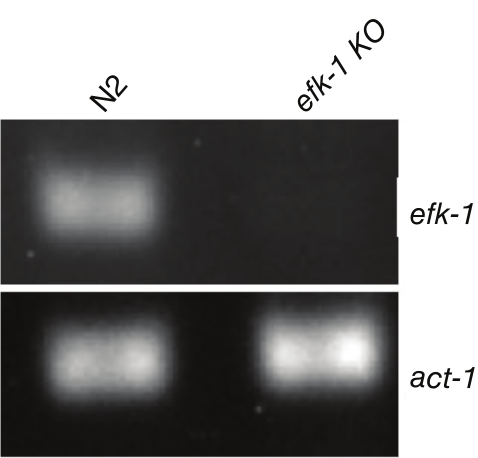
Figure 1. efk-1 knockout confirmation by PCR. An efk-1 fragment (~790 bp) was amplified by PCR using specific primer pair to verify the knockout background ( efk-1 KO) using N2 worms as positive control and act-1 amplification as load